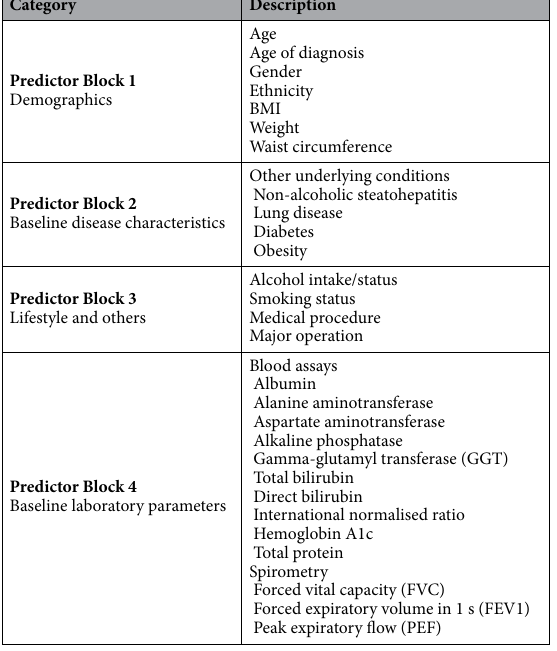
Table 3. Description of potential predictor variables. Variables in predictor blocks 2 and 3 were obtained from patient-reported questionnaires. There may be more than one predictor variable in each predictor category. 58 predictor variables were identified via feature selection prior to ML model